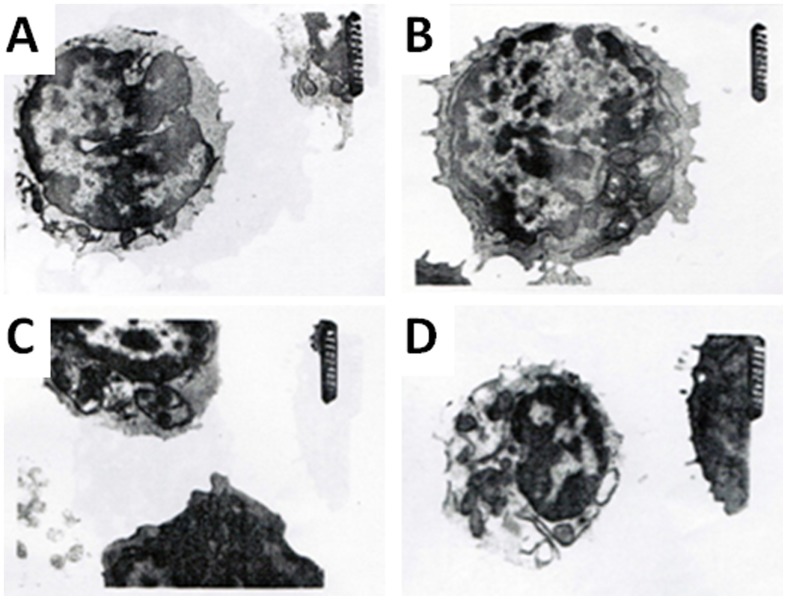
The structure of lymphocytes in control group (a) and VMD patients showing swelling of mitochondria and deletion mitochondrial membrane phospholipids (b, c, d).(magnification 10,000X).